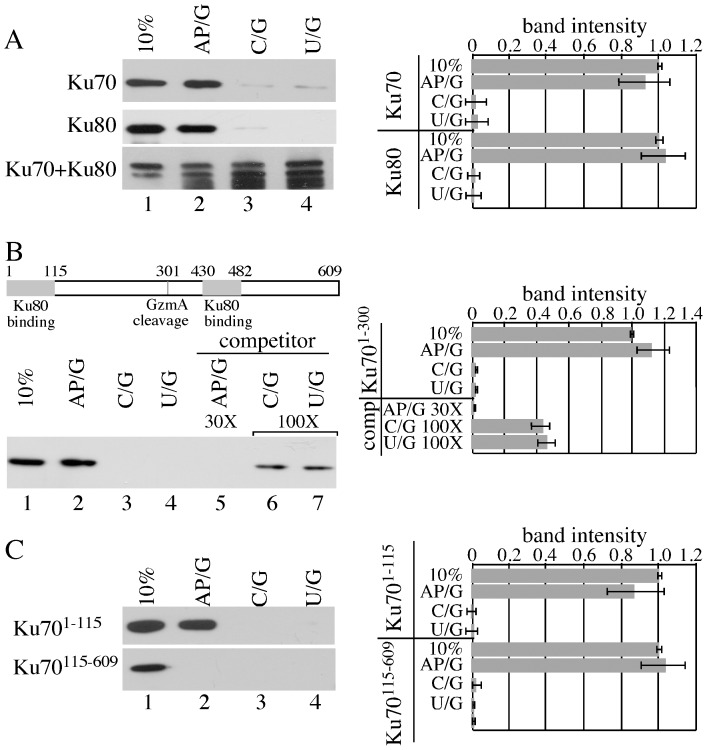
Ku70 and Ku80 bind to AP sites.We show 10% input for in vitro translated product. The same concentration of biotinylated substrate were used for each reaction of the binding assays. Right panel shows the relative band intensity as measured with the Kodak document program and as compared to 10% input. Shown is the average of three experiments with error bars (standard deviation). Statistics are shown in the results. (A) Ku70 and Ku80, but not Ku70+Ku80, preferentially bind to the AP site. (B) GzmA cleaves Ku70 at Arg(301). Cleavage at this site separates the two Ku80 binding domains. The GzmA N-terminal Ku70 cleavage product (Ku701–300) binding and competition assays. (C) Ku701–115, but not Ku70115-609, bound to the AP/G substrate at a higher level than the C/G and U/G substrates.